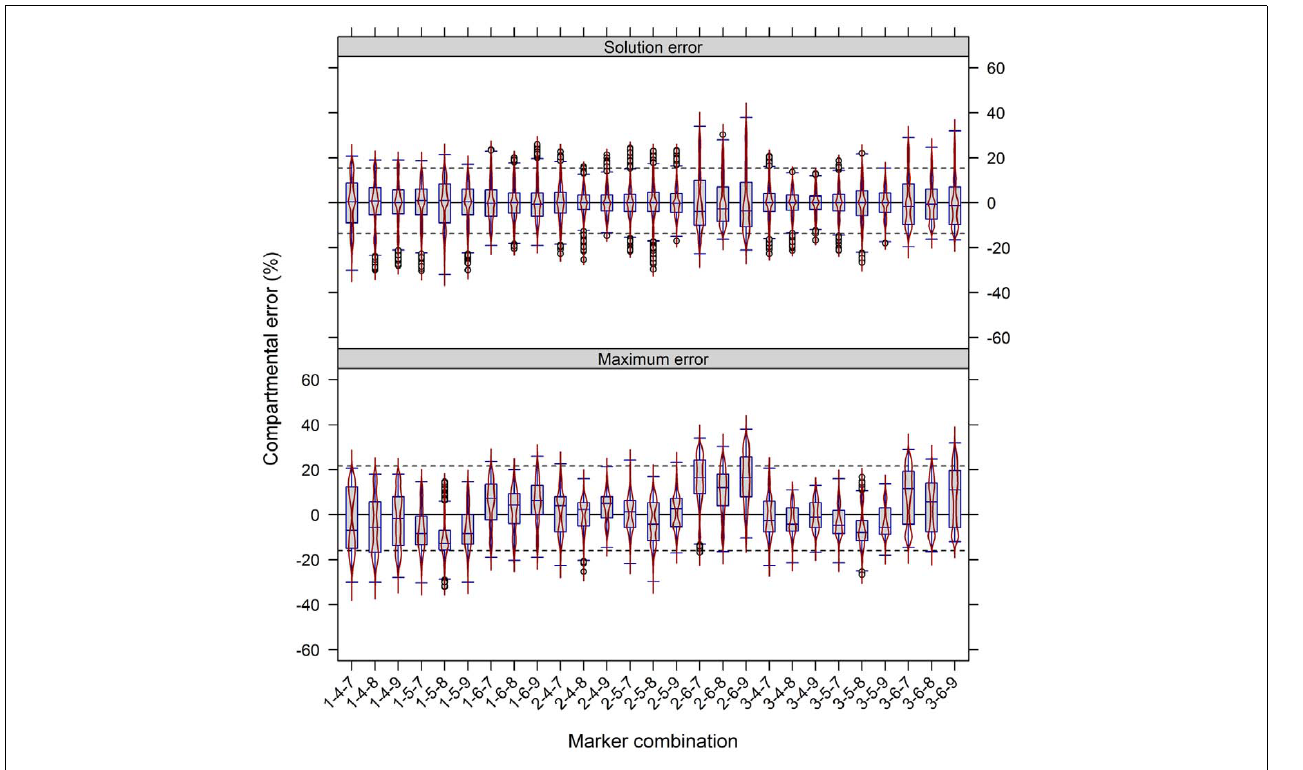
5th and 95th percentiles among all combinations are drawn as black dashed lines. Marker 1–3, 4–6, and 7–9 represent the plastids, the cytosol, and the vacuole, respectively. Plastids: 1 – glyceraldehyde-3-phosphate dehydrogenase (GAPDH), 2 – starch, 3 – Digalactosyldiacylglycerols (DGDGs); Cytosol: 4 – Uridine diphosphate – glucose-pyrophosphorylase (UGPase), 5 – glyceroceramids (GlcCer), 6 – triacylglycerides (TAGs);Vacuole: 7 – nitrate, 8 – glucosinolates, and 9 –